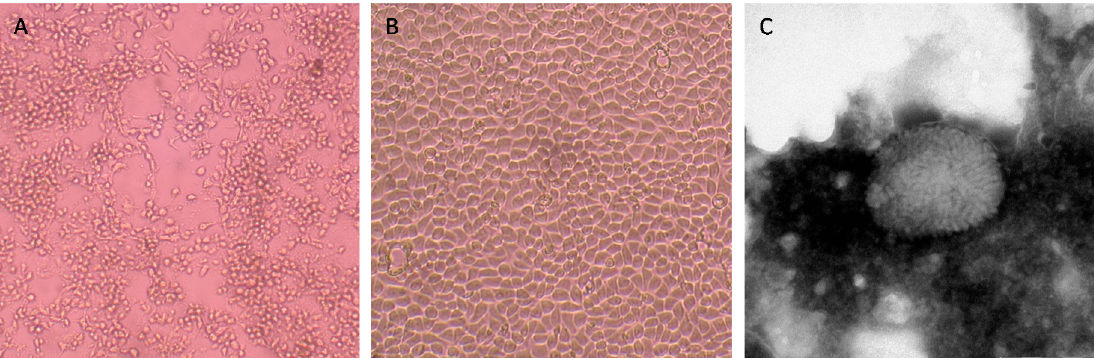
Figure 1. ( a ) Cytopathic effects (CPEs) of rounded cells floating in the culture medium of MARC 145 cells infected with the pool of bat organs (heart and lungs) at three days after inoculation (original magnification × 100); ( b ) mock cells (original magnification × 100); ( c ) negative-staining electron microscopy showing the presence of a virion morphologically related to the Orthopoxvirus genus from the MARC 145 cell culture.